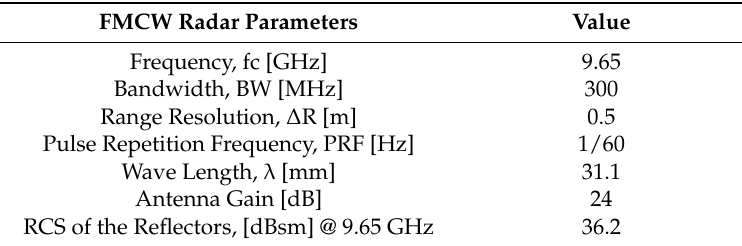
Table 1. Key radar